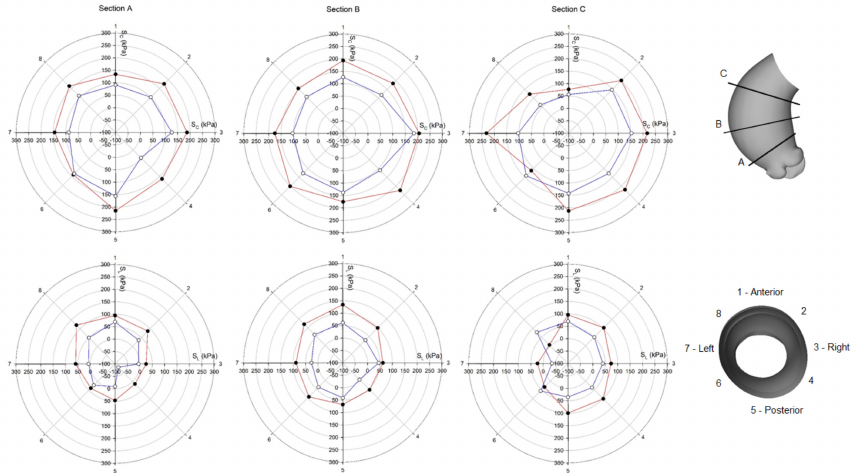
Figure 6. Polar plot of stress distribution along three different sections for ATAA LHHM at systolic peak for both the inner aortic wall surface (red lines) and the outer aortic wall surface (blue lines).